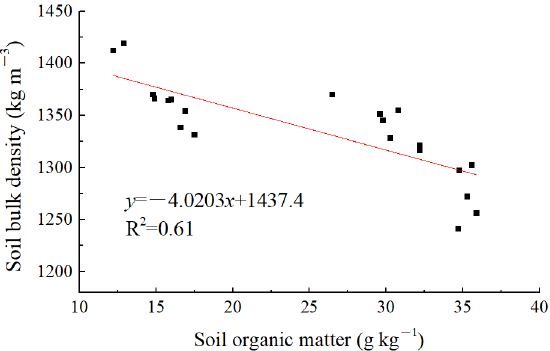
Figure 6. Relationship between soil organic matter (SOM) and bulk density under traditional tillage (TT) and cattle manure mixing (CM) treatments.